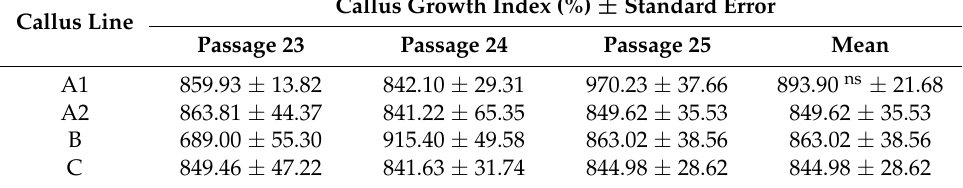
Table 1. The growth parameters of selected lines of Chaenomeles japonica callus growing on various variants of MS (Murashige and Skoog) medium.